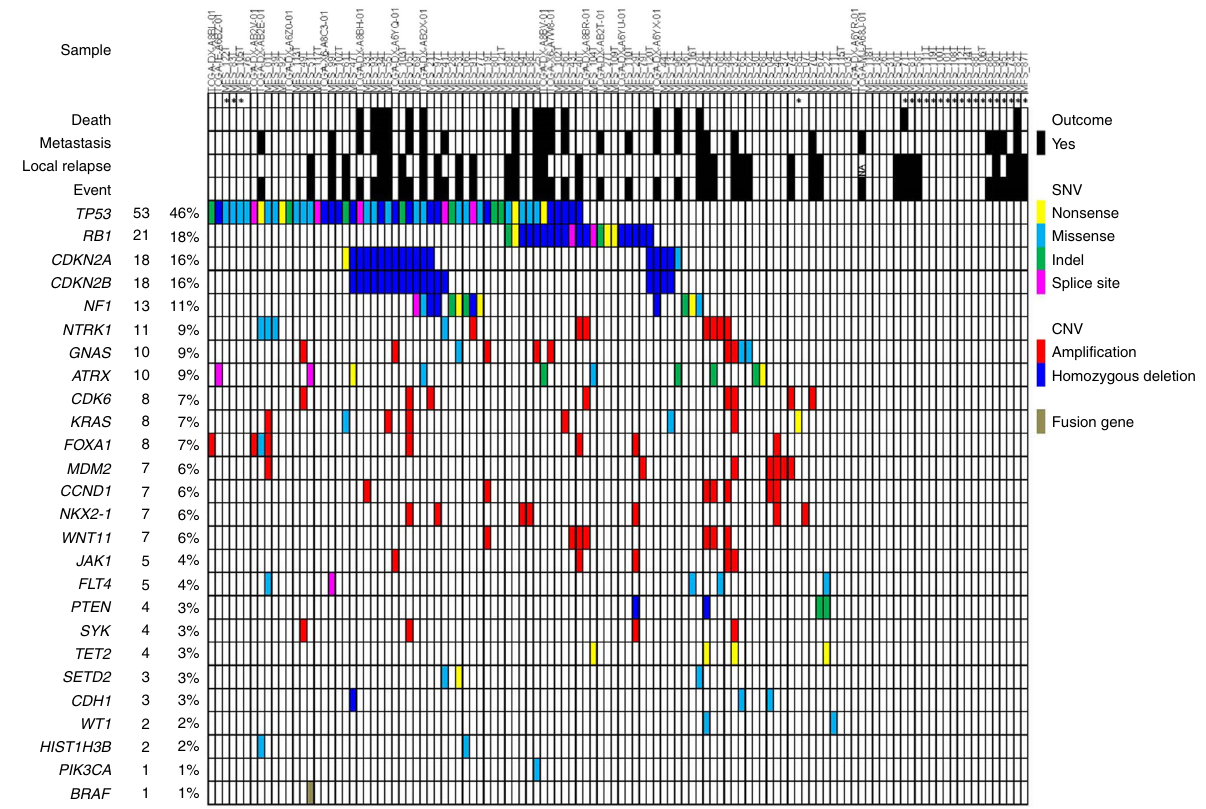
Fig. 1 Driver gene landscape in 116 MFSs. Driver genes are ranked according to their frequencies of mutations. In each pathway, mutually exclusive pro fi le was found: RB1 , CDKN2A / CDKN2B , and CCND1 in p53 signaling and the cell cycle G1/S checkpoint pathways; NF1 , NTRK1 , KRAS , PTEN , SYK , PIK3CA , and BRAF in the RTK-RAS-PI3K pathway; and ATRX , TET2 , SETD2 , WT1 , and HIST1H3B in regulators of the